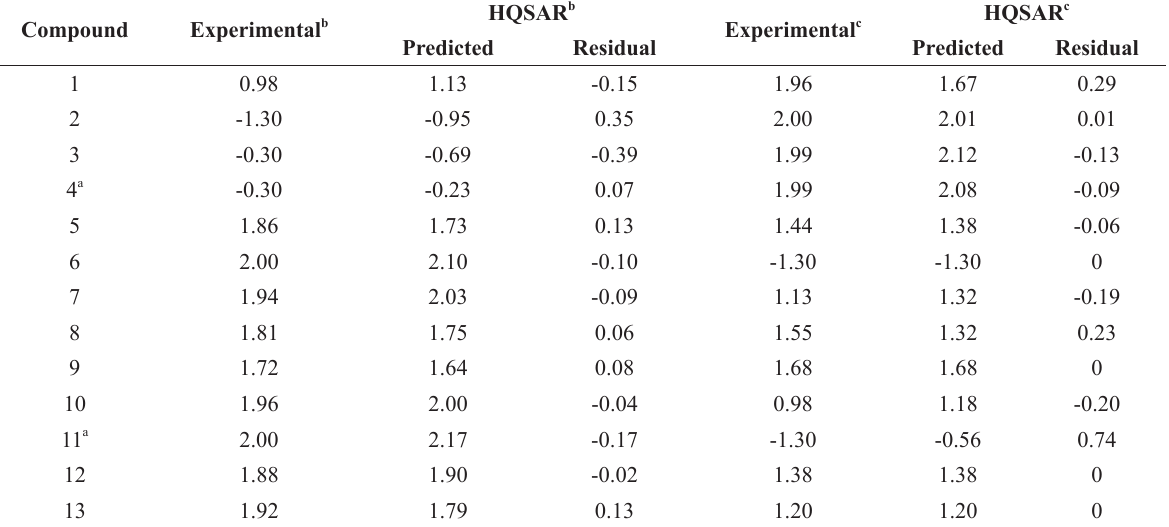
Experimental and predicted log percentage values of ( S )- and ( R )-enantiomers